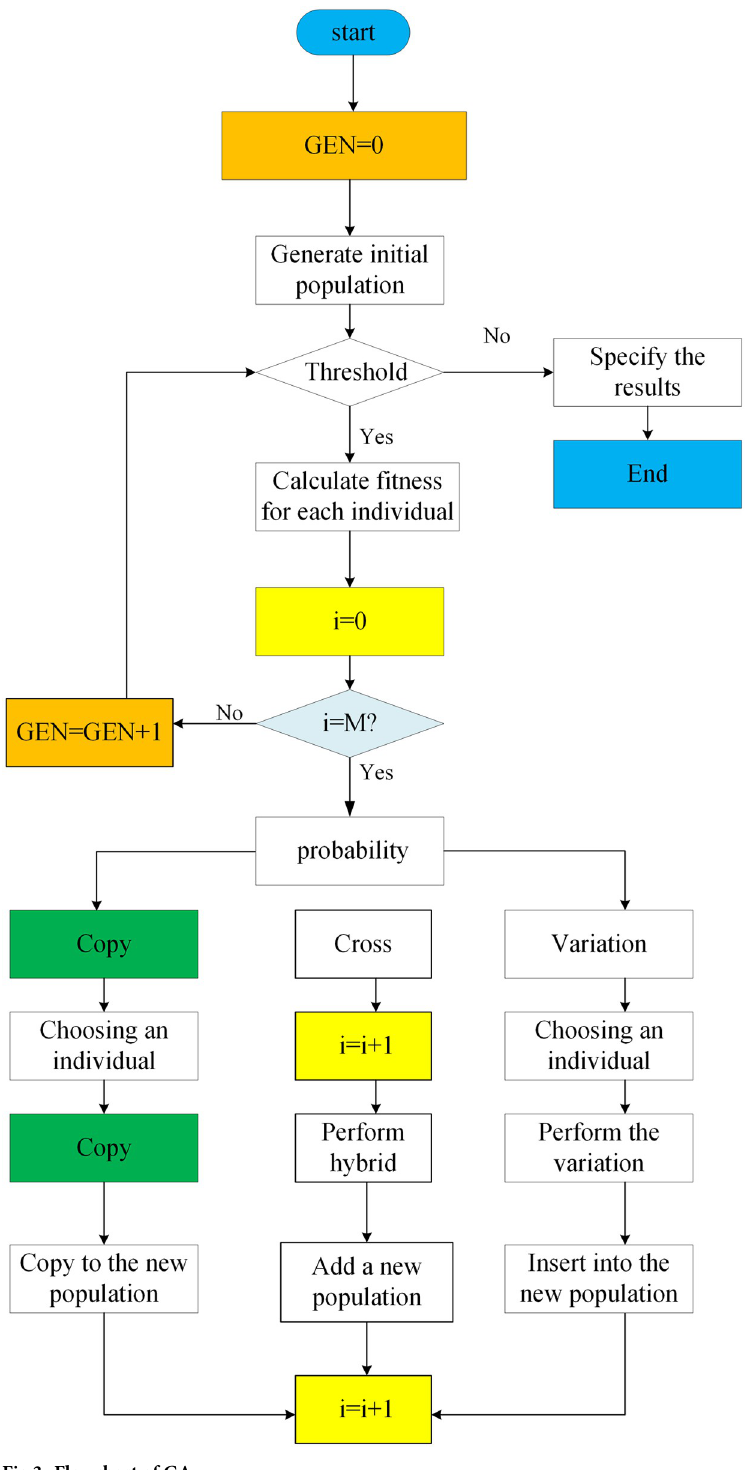
Fig 3. Flowchart of